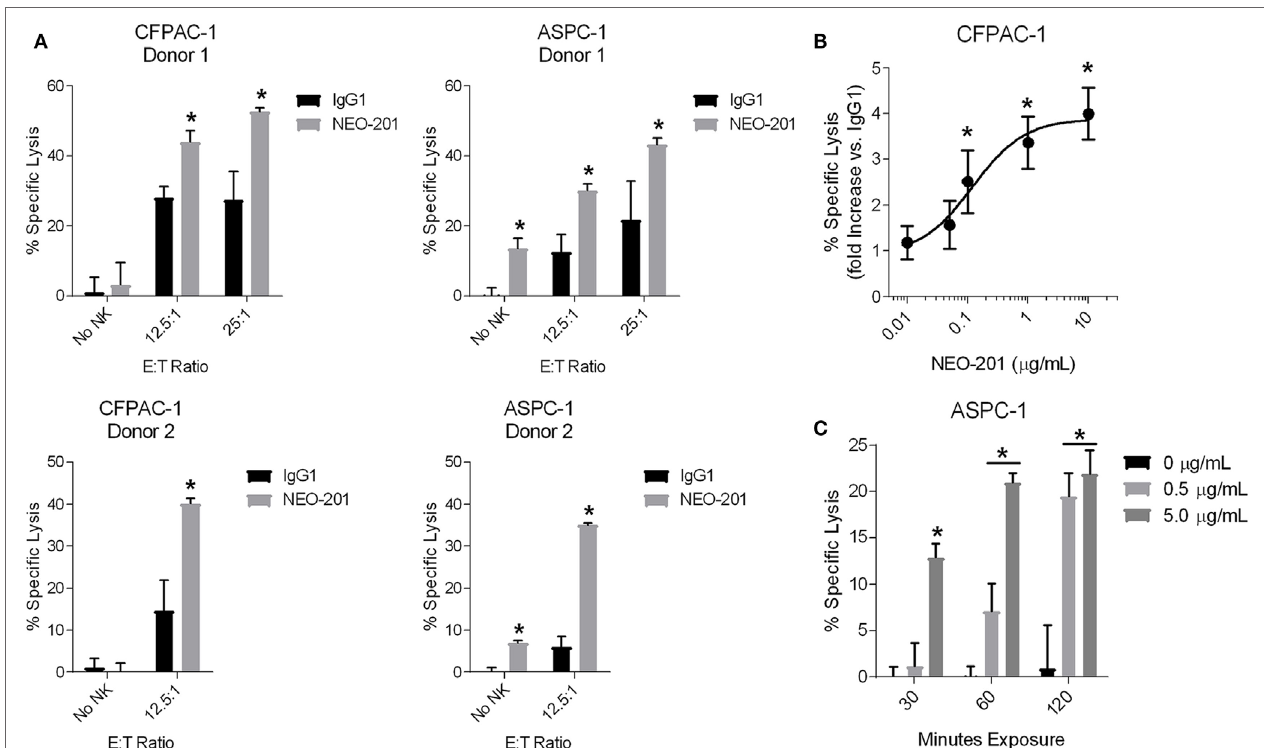
FigUre 3 | NEO-201 mediates ADCC and CDC against human tumor cell lines. (a) ADCC activity using CFPAC-1 or ASPC-1 cells as target cells. Cells were treated with 10 µg/mL of NEO-201 or human IgG1 (negative control). Purified natural killer (NK) cells from two healthy donors were used as effector cells at the indicated E:T ratios. *Statistically significant ( p < 0.05) by T -test. (B) ADCC assay using CFPAC-1 cells treated with increasing doses of NEO-201. NK cells isolated from a healthy donor were used as effector cells at an E:T ratio of 12.5:1. The graph depicts the fold increase in % specific lysis of NEO-201-treated tumor cells versus that of control cells treated with 10 µg/mL human IgG1. *Statistically significant ( p < 0.05) by T -test. (c) CDC assay using ASPC-1 cells treated with rabbit complement (1:8 dilution) and the indicated doses of NEO-201 for the indicated durations. *Statistically significant ( p < 0.05) by T